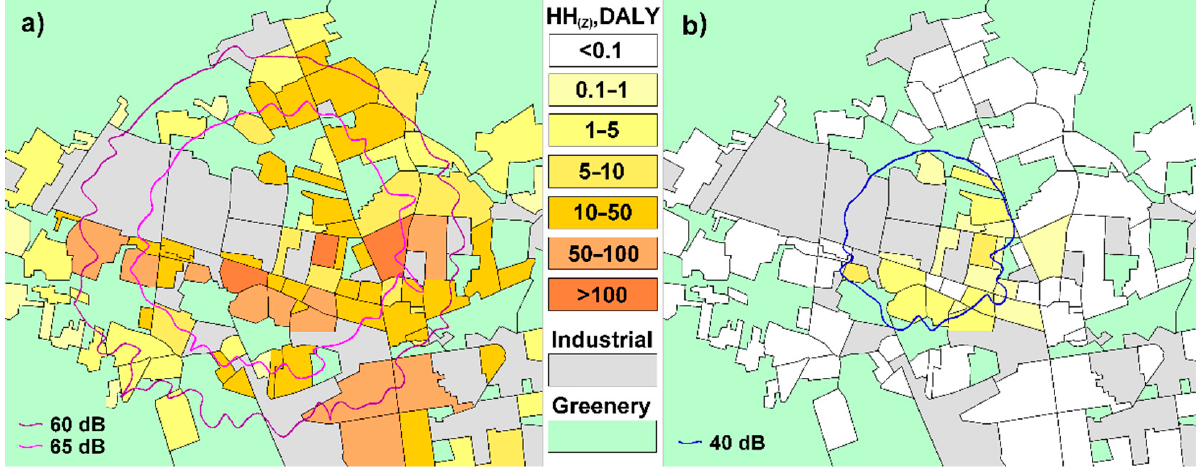
Figure 5. Endpoint indicator increase resulting from noise due to steam discharge, ( a ) without the silencer use, ( b ) with the silencer use. Table 1. Total midpoint and endpoint human health indicators associated with background and steam discharge